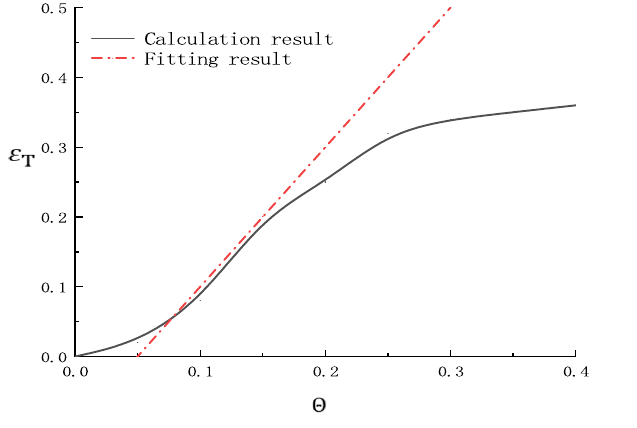
Figure 5. Correspondence between ε T and (cid:31)